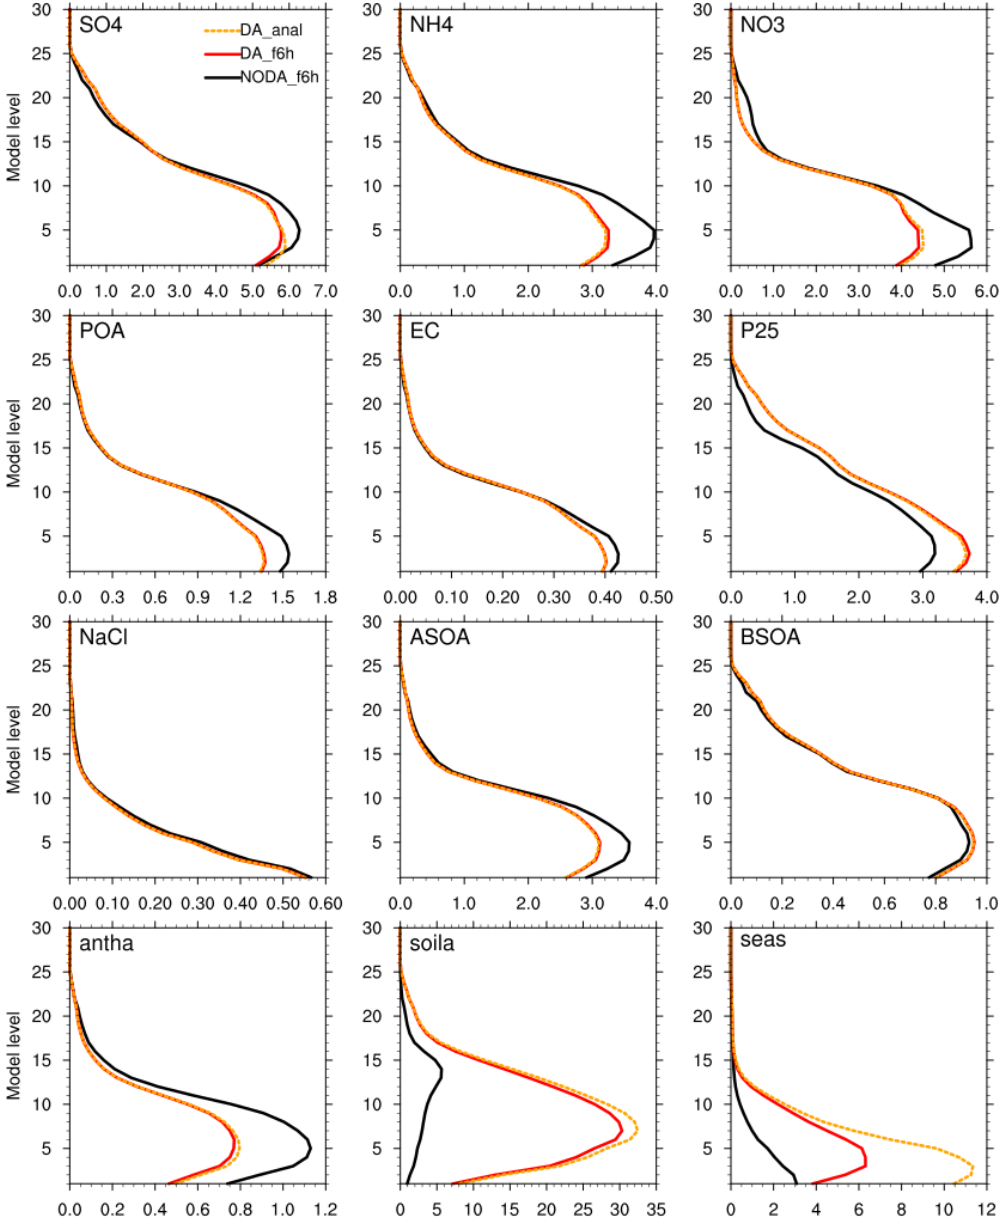
Figure 10. Vertical profile of aerosol species ([µgkg − 1 ]) averaged over domain 2. The 6h forecasts in NODA (black) and DA (red) are depicted with solid lines, while the analyses in DA are indicated by the dotted orange line. Table 5. Categorical forecasts for different air pollution